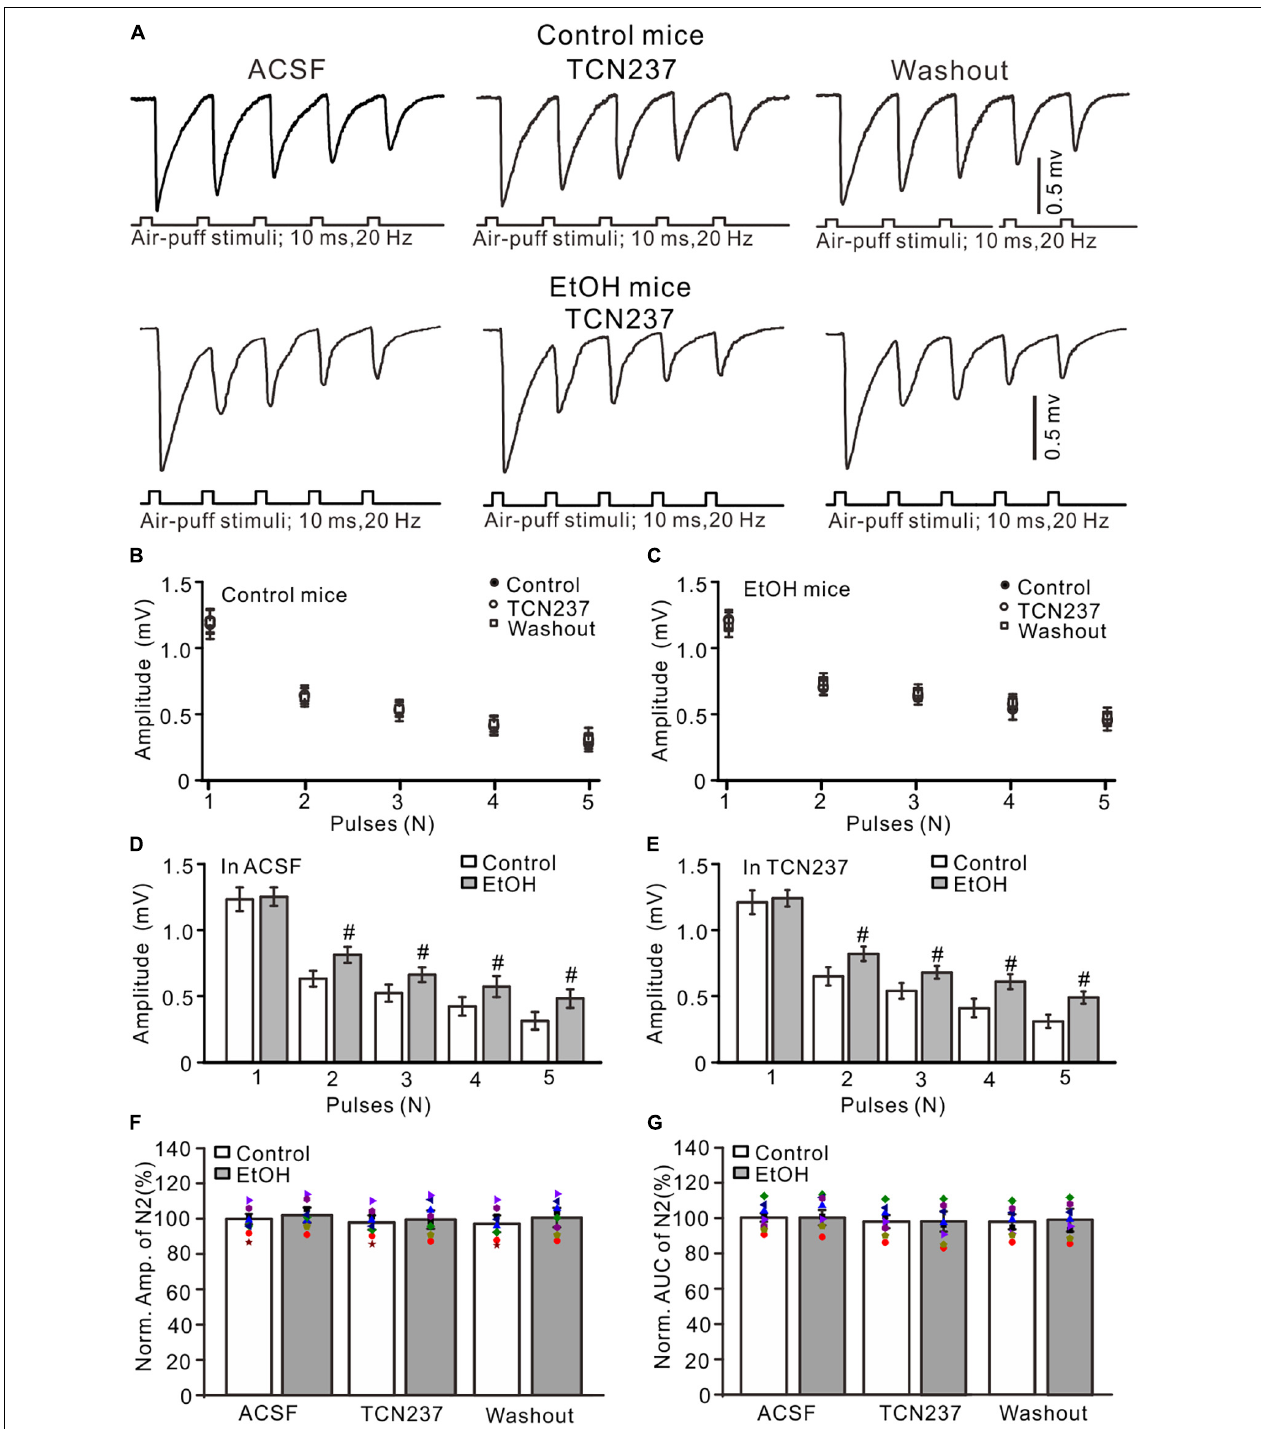
FIGURE 4 | GluN2B blockade failed to prevent the ethanol exposure-induced enhancement of facial stimulation-evoked MF–GC synaptic transmission. (A) Representative field potential traces showing that the air-puff stimuli (10 ms, 60 psi; 5 pulse, 20 Hz) on the ipsilateral whisker pad evoked field potential responses, recorded from the GL of control (upper) and ethanol-exposed mice in treatments of ACSF, TCN (10 µ M), and recovery (washout). (B) Summary of data showing the absolute amplitudes of N1–N5 in treatments with ACSF, TCN (10 µ M), and recovery (washout) in control mice. (C) Summary of data showing the absolute amplitudes of N1–N5 in treatments with ACSF, TCN, and recovery (washout) in ethanol-exposed mice. (D,E) Bar graphs with individual data showing the normalized amplitude of N2 in ACSF (D) and in TCN237 mice. (F,G) Bar graphs with individual data (Symbols of different colors) showing the normalized amplitude (F) and AUC (G) of N2 in control and ethanol-exposed mice. n = 8 in each group. # P < 0.05 vs.